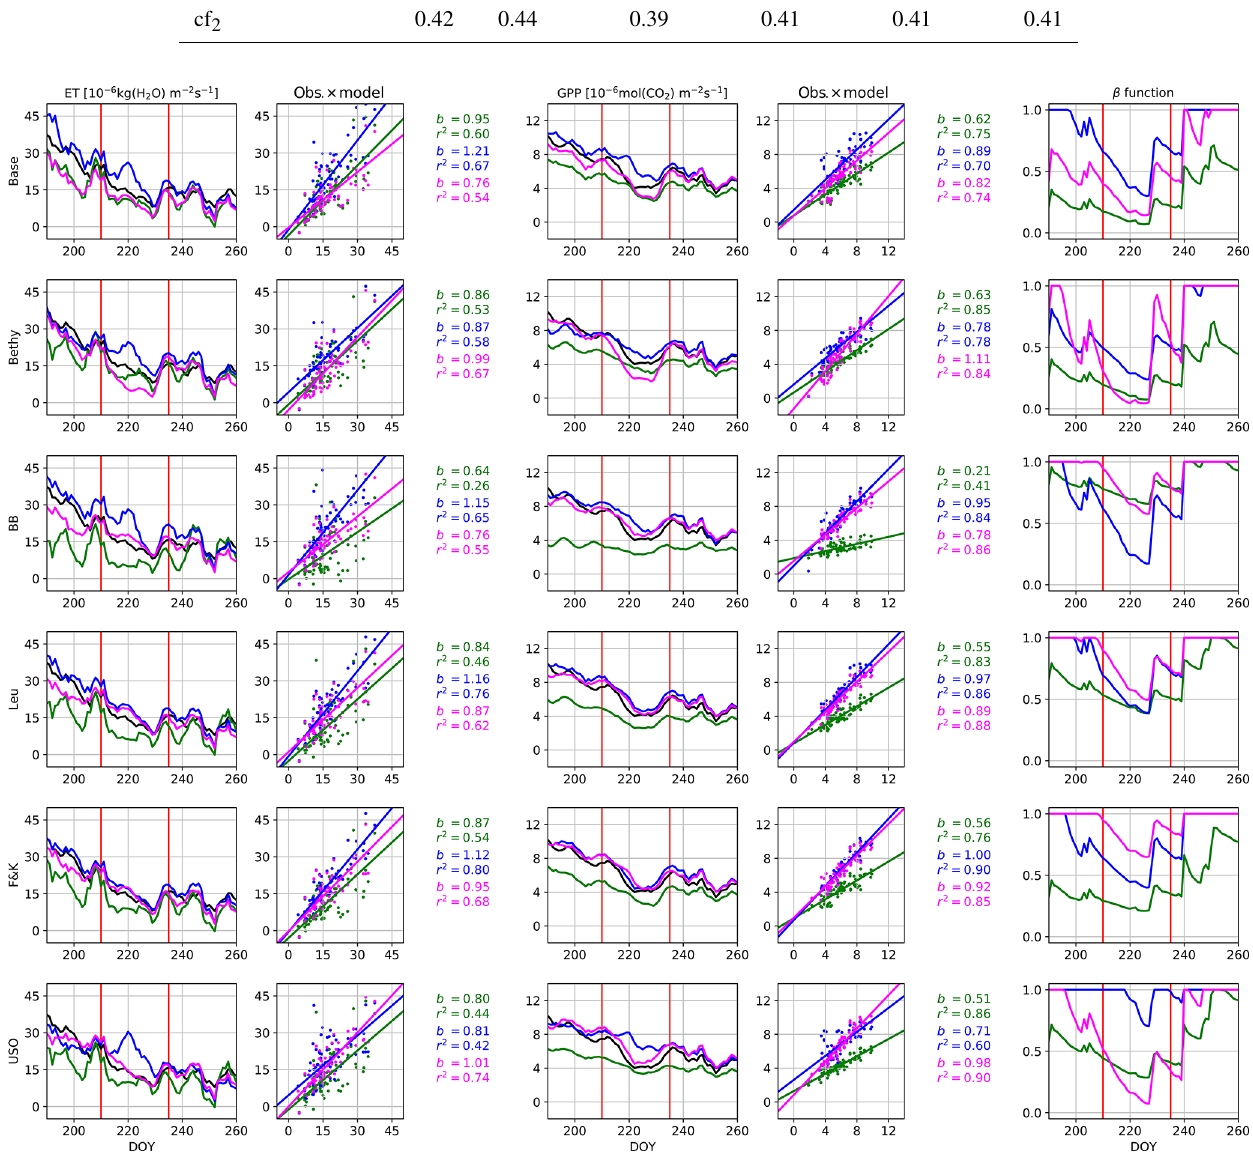
Figure 3. Hyytiälä site drought in summer 2006. The time series for evapotranspiration and gross primary production are 5d running averages and for β -function daily values. The observations are plotted in black and the model with default parameterisation in green, calibration period optimisation in blue and the dry-year optimisation in magenta. The red vertical lines indicate the start and end of the actual